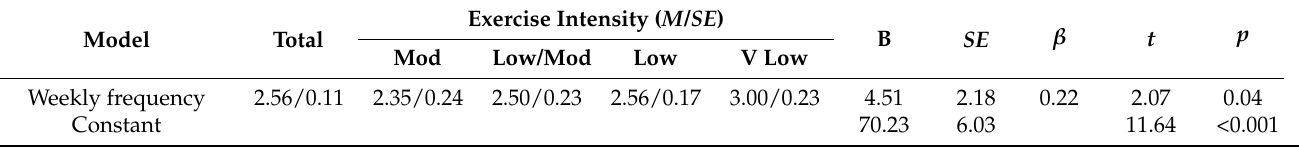
Table 3. Multiple regression of participant characteristics on baseline HEG.